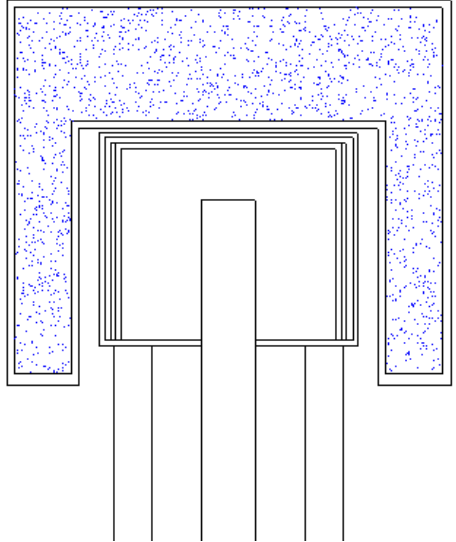
Figure 2. The photons (blue dots) being emitted in the filling of M600 Marinelli